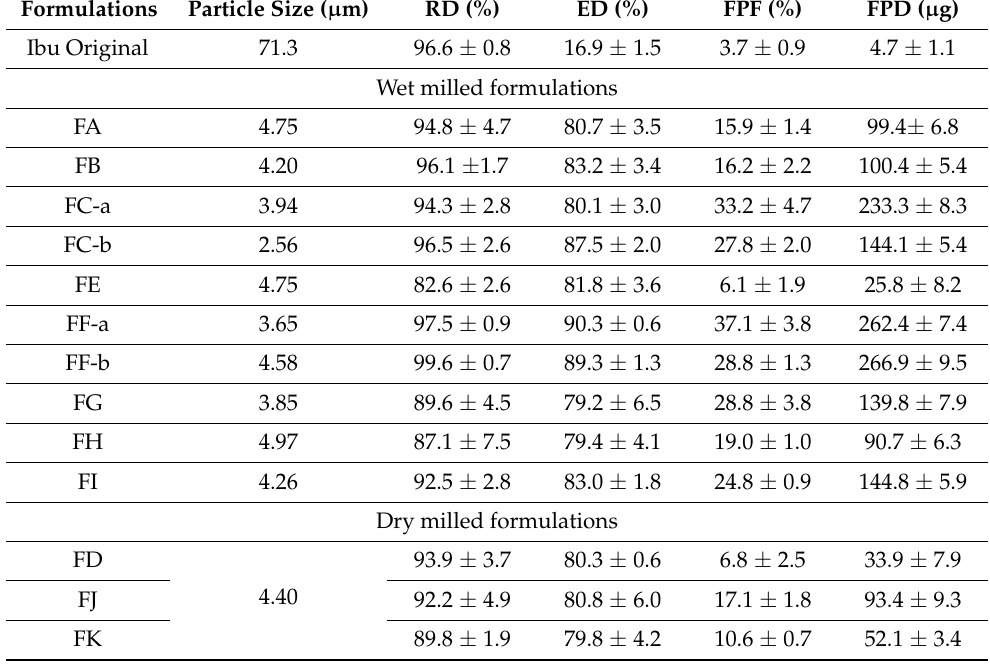
Table 4. IBF deposition from DPI formulations using TSI through a Breezhaler ® (Mean ± SD, n = 5).